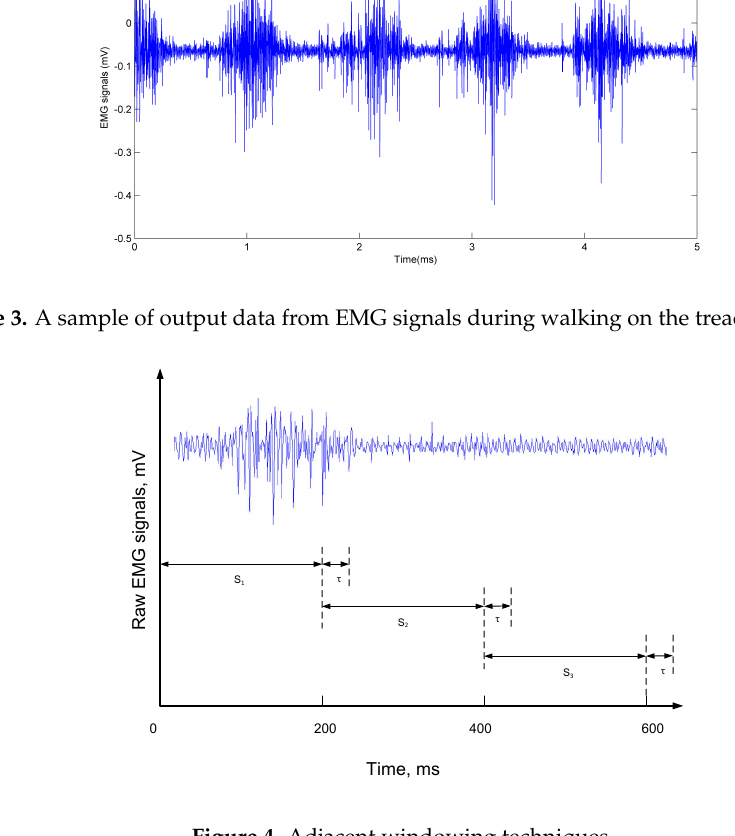
Figure 4. Adjacent windowing